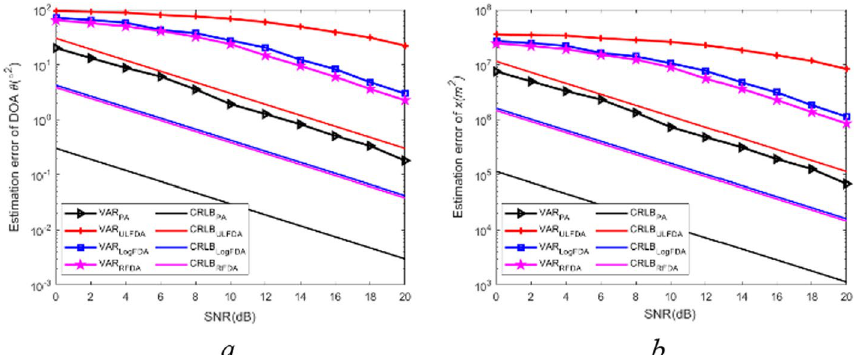
Fig. 9 Estimation error with SNR. a DOA estimation and b Location estimation